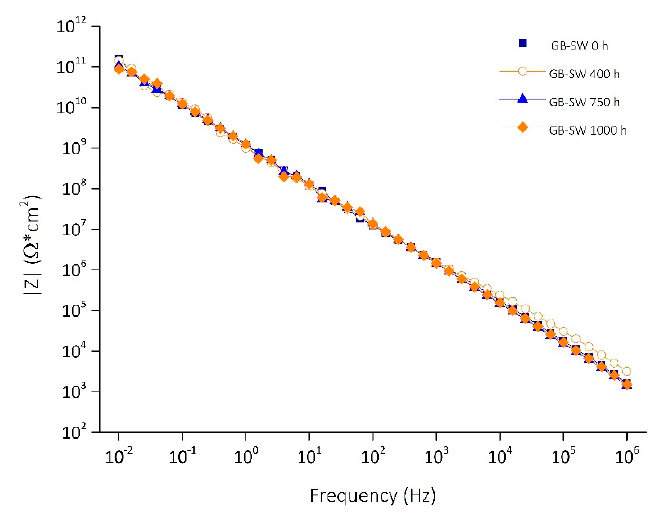
Figure 10. Bode diagram of the GB-SW sample at different acetic salt spray exposure times.